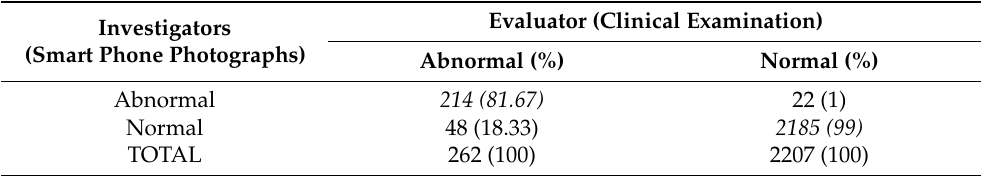
Table 3. Sensitivity and specificity considering photographs with disagreement as normal.